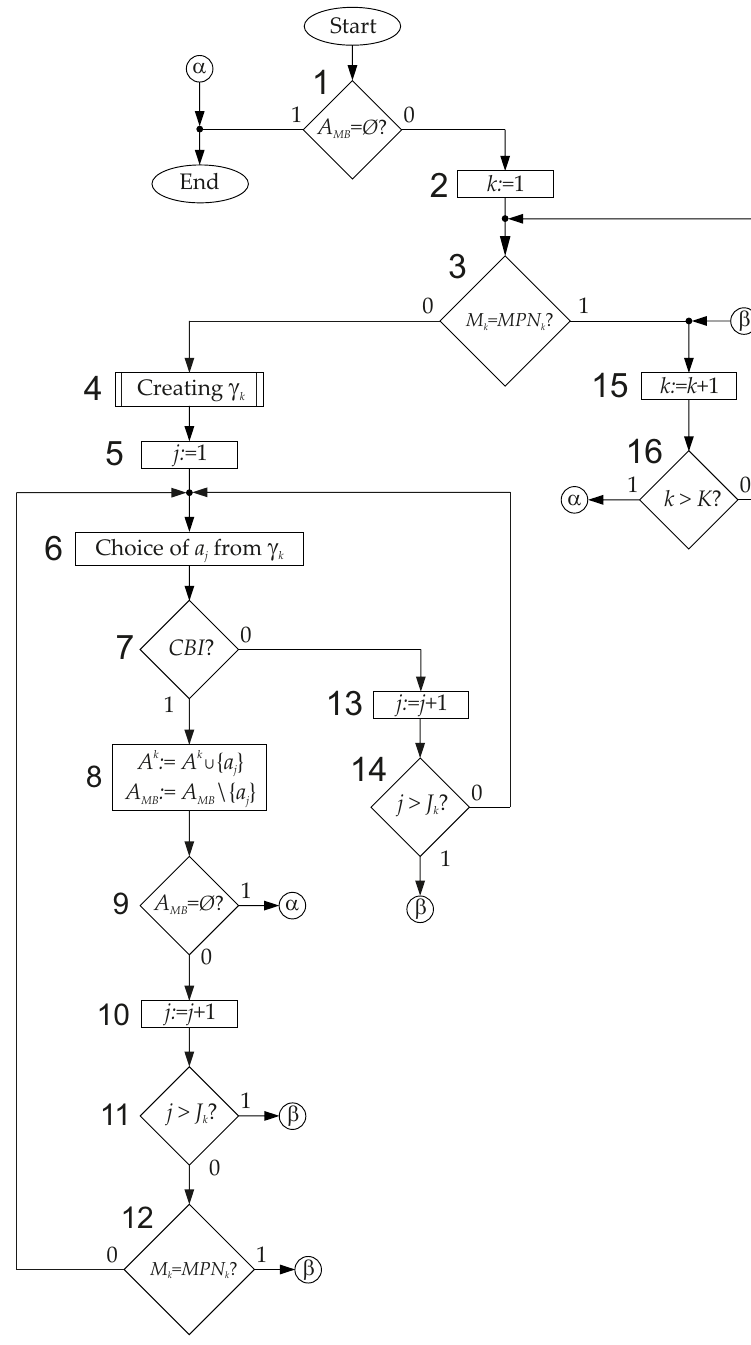
Figure 9. Block-diagram of state redistribution